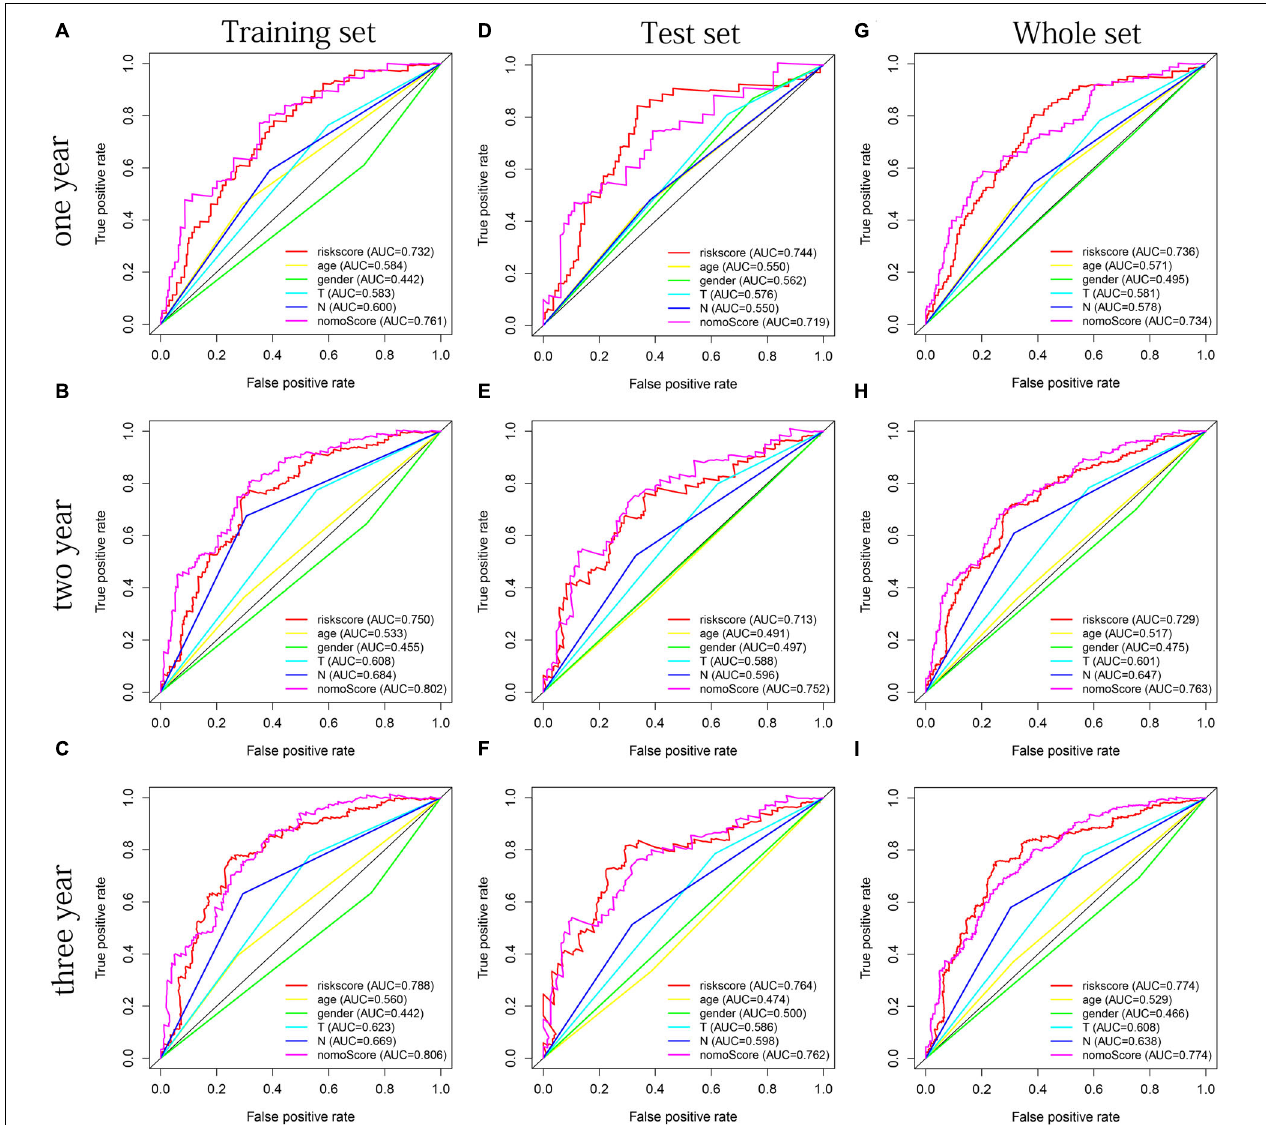
FIGURE 12 | The multifactor ROC curves confirm the best predictive performance of nomogram. (A–C) One, 2, and 3 years of multifactor ROC curves in training set, respectively. (D–F) One, 2, and 3 years of multifactor ROC curves in the test set, respectively. (G–I) One, 2, and 3 years of multifactor ROC curves in the whole set,